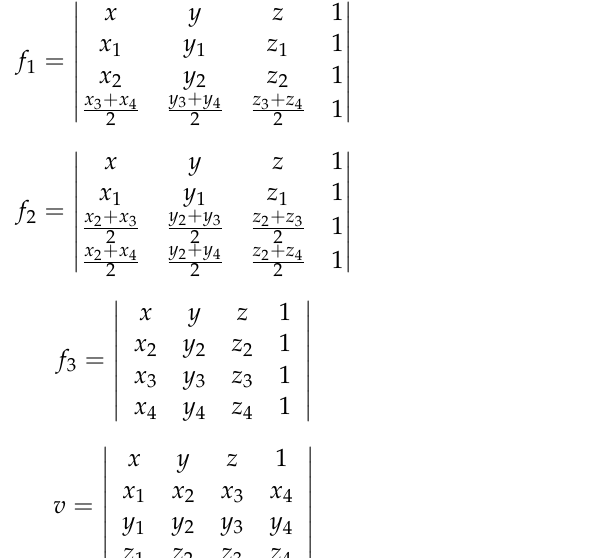
Figure 5. Schematic of the convex aggregate spli tt ing process.